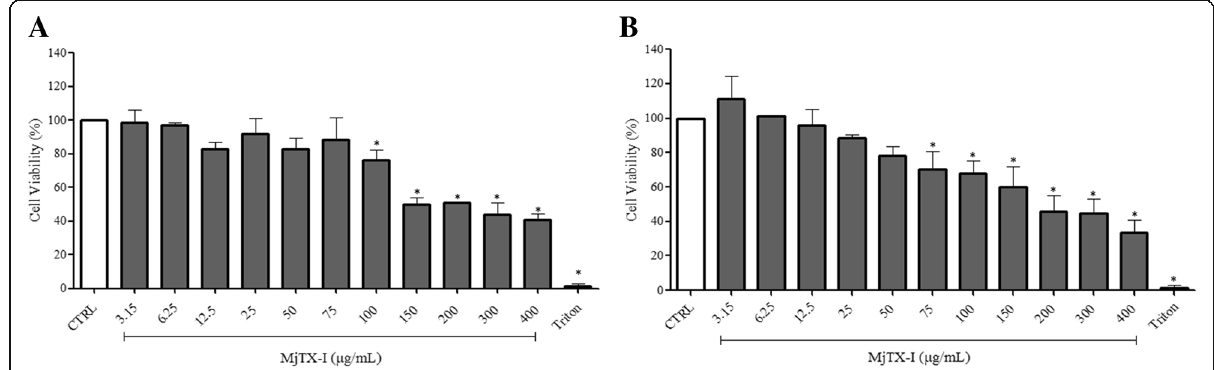
Fig. 1 Cytotoxicity of MjTX-I towards ( a ) K562-S ( b ) K562-R tumor cell lines. Results are expressed as the mean percentage of cell viability ± standard deviation of three independent experiments assayed in triplicate. CTRL: untreated cells (negative control). * p < 0.05 vs. CTRL (One-way ANOVA followed by the Tukey ’ s post-hoc